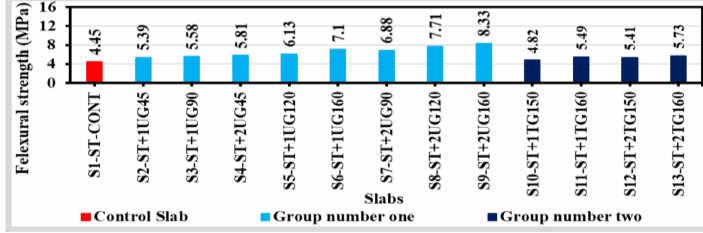
Figure 12. The Post-peak flexural strength values for each concrete slab in comparison to the concrete control slab.